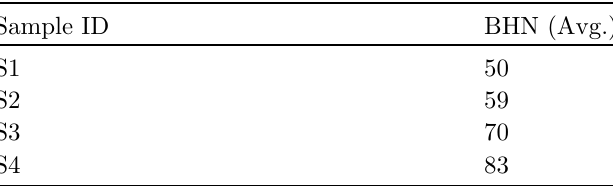
Table 3. Hardness of homogenized castings. Sample